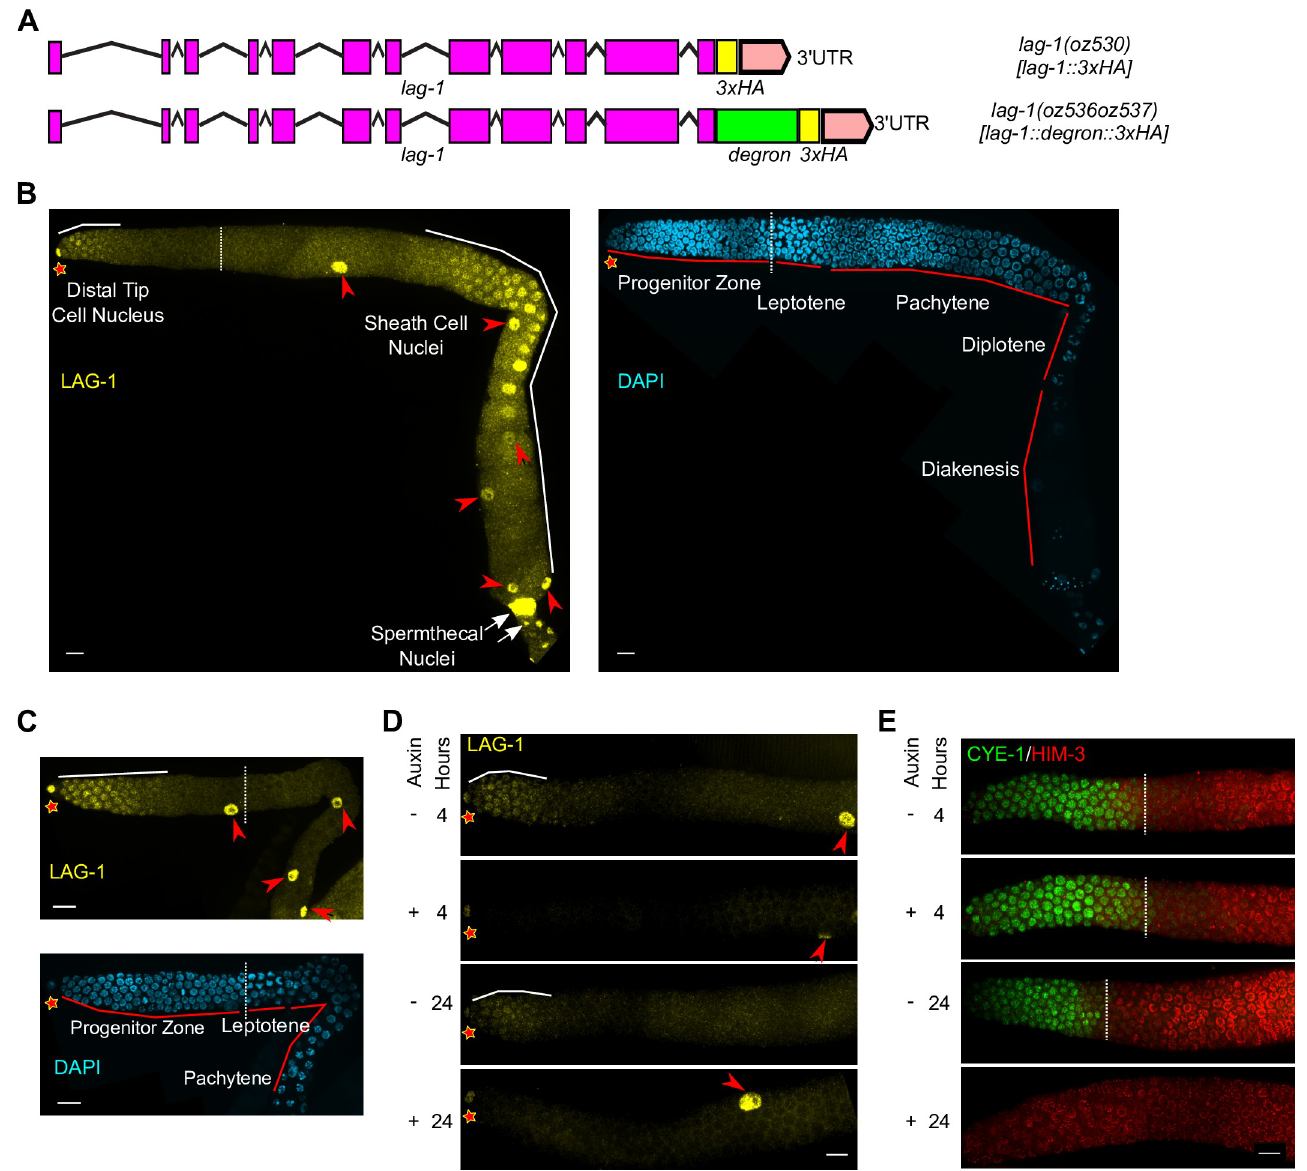
Fig 2. LAG-1 spatial accumulation and germline autonomous function to promote the stem cell fate. (A) Diagrams of tagged endogenous lag-1 alleles, lag-1 (oz530[lag-1 :: 3xHA]) (top) and lag-1(oz536oz537[lag-1 :: degron :: 3xHA]) (bottom). Purple boxes, exons; lines, introns; pink boxes, untranslated region; yellow boxes, 3xHA; green box, degron. (B & C) Images of HA-stained (LAG-1, yellow) germlines from dissected hermaphrodite gonads, co-stained with DAPI (cyan) for (B) 1-day adult and (C) mid-L4 stage. (D & E) Images of (D) HA-stained (LAG-1, yellow) and (E) CYE-1 (green), HIM-3-stained (red) germlines from dissected hermaphrodites. L4 stage animals with the following genotype lag-1(oz536oz537[lag-1 :: degron :: 3xHA]); ieSi64[gld-1p :: TIR1 :: mRuby :: gld-13'UTR] were treated with or without auxin for 4 hours (top two panels) or 24 hours (bottom two panels). Note that depending on the orientation of the gonad when mounted for microscopy, two, one or zero distal sheath cell nuclei are visible in the surface views of the germline shown in the photographs. Star, distal end; dashed lines, position of meiotic entry; solid white lines, position of LAG-1 accumulation; red arrowheads, sheath cell nuclei; white arrows, spermatheca nuclei. Scale bar is 10 μ m. of LAG-1 for early embryonic GLP-1 signaling in specification of certain blastomere cell fates [35,36]. In mid/late L4, LAG-1::HA was also found in germ cell nuclei in the distal most ~10 cd of the PZ, but not observed in late pachytene cells in the proximal gonad, which correspond to germ cells undergoing spermatogenesis [37]. Distal germline LAG-1::HA staining was